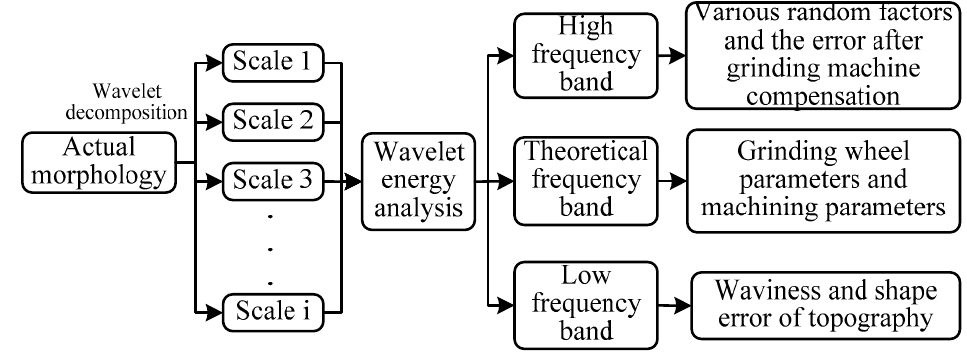
Figure 2. Decomposition process of surface topography signal.